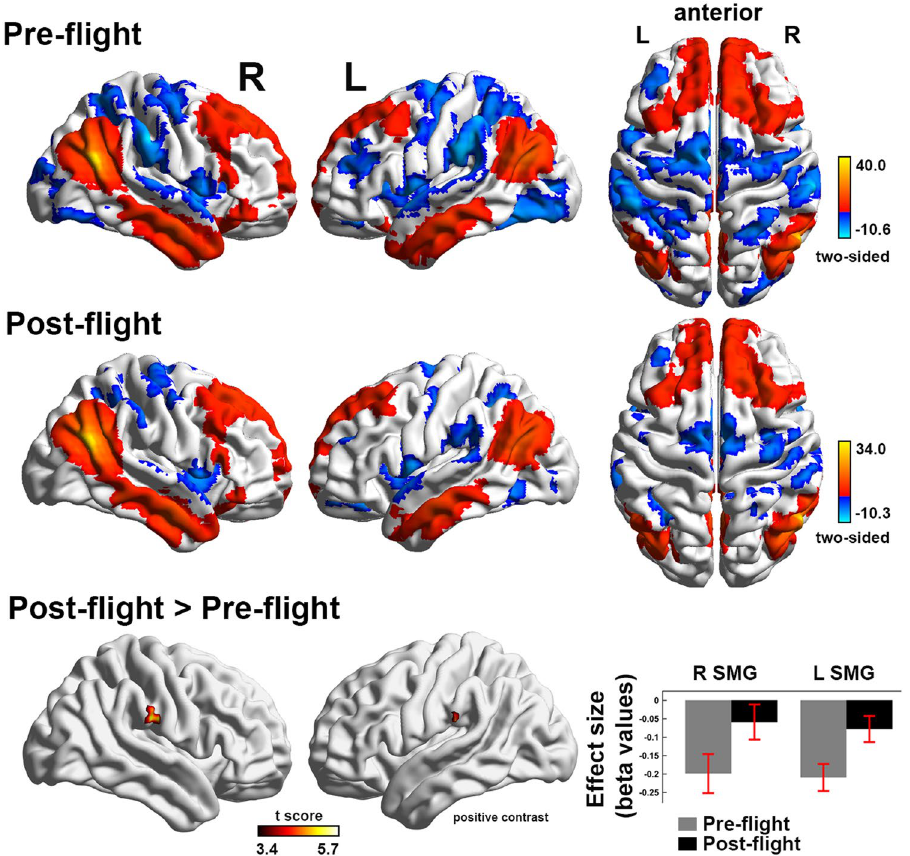
Figure 4. The networks encompassed by the right angular gyrus/temporo-parietal junction in the parabolic flight group. The default mode network (DMN; red) and the DMN anticorrelated regions (blue) were the set of areas that were functionally connected with the right angular gyrus at pre- and post-flight. The between- condition differences in the encompassed networks included fewer anticorrelations with bilateral supramarginal gyri. The statistical maps are rendered on a surface template and have been thresholded at cluster-level family wise error rate p < 0.05 (permutation tests). Bars indicate cluster-level effect sizes (beta values) and error bars 90%